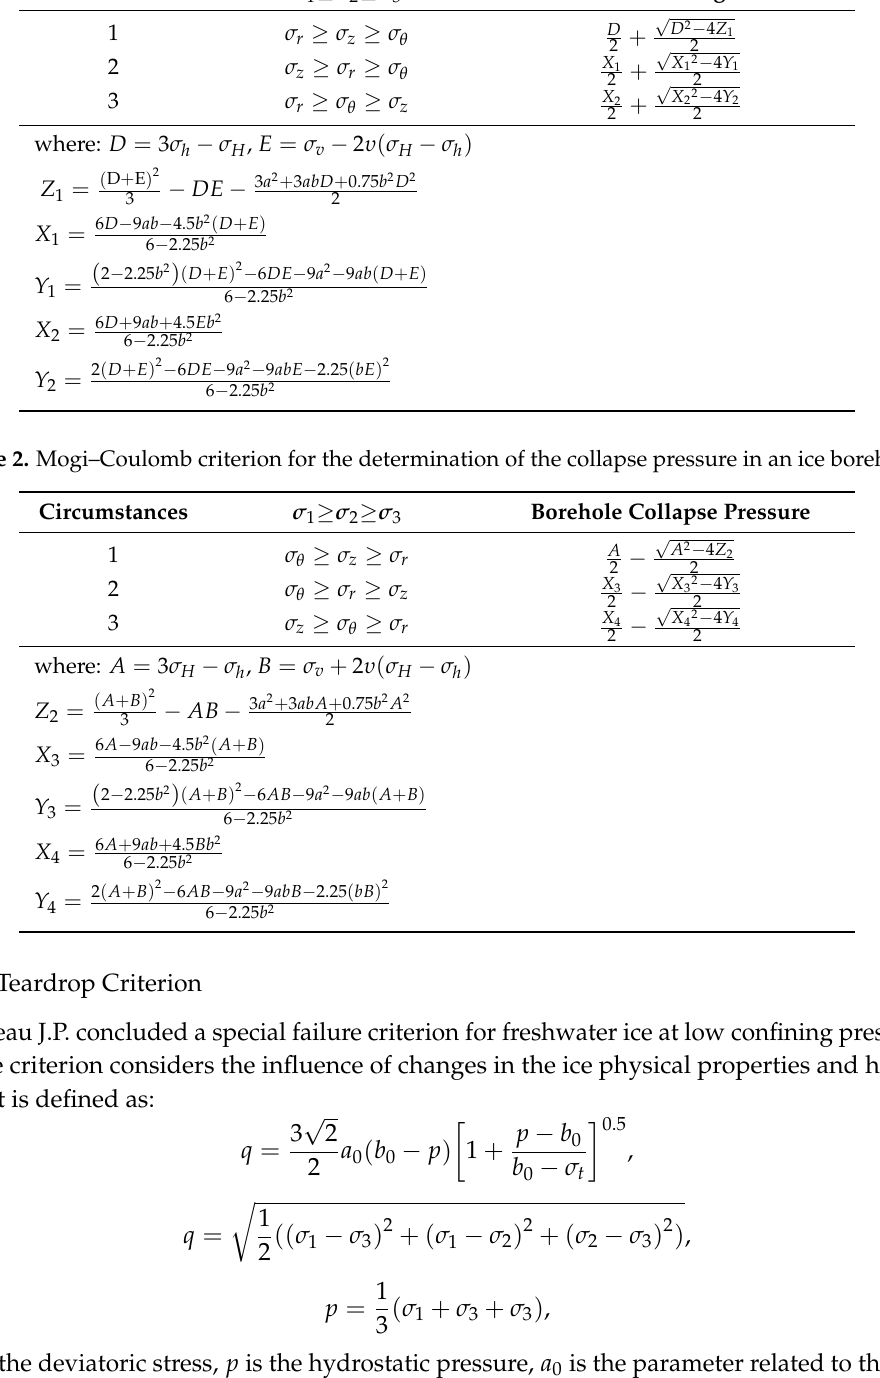
Table 1. Mogi–Coulomb criterion for the determination of the fracturing pressure in an ice borehole. Circumstances